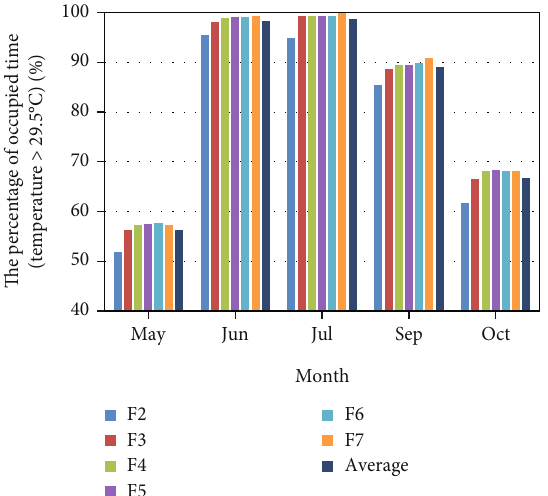
Figure 13: The percentage of time of thermal discomfort (based on temperature > 29.5 ° C).